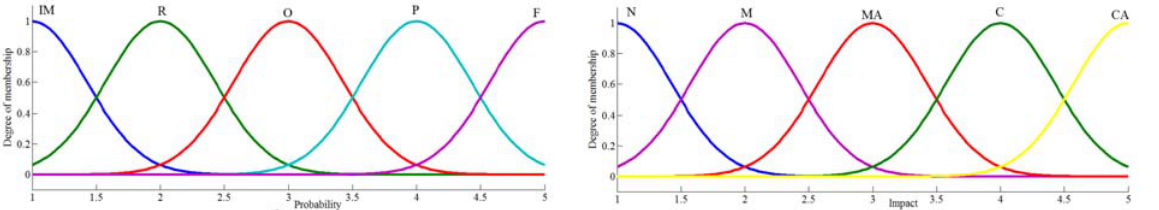
Fig. 6. Membership function for impact levels